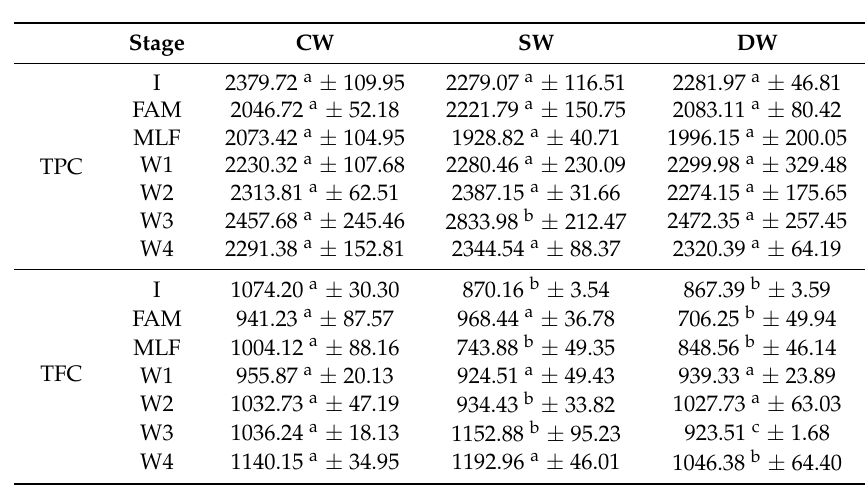
Table 2. Total phenolic content (TPC) and total flavonoid content (TFC) in red wines, at the different stages of